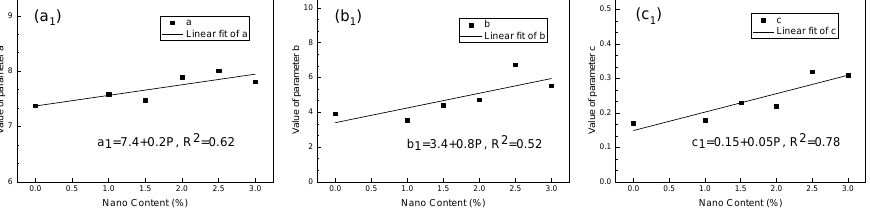
Figure 3. Relationships between breaking strength parameters value and nano content. ( a 1 ) Correlation between parameter a 1 and NS content; ( b 1 ) Correlation between parameter b 1 and NS content; ( c 1 ) Correlation between parameter c 1 and NS content.